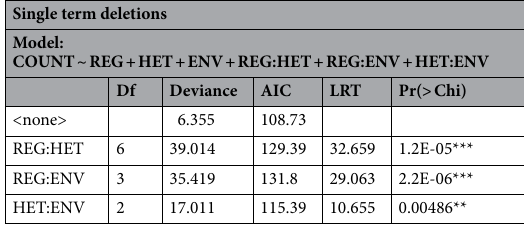
Table 4. Analysis using LRT showed significant association between two terms of the three factors tested. Signif. codes: ‘***’ 0.001 ‘**’ 0.01.